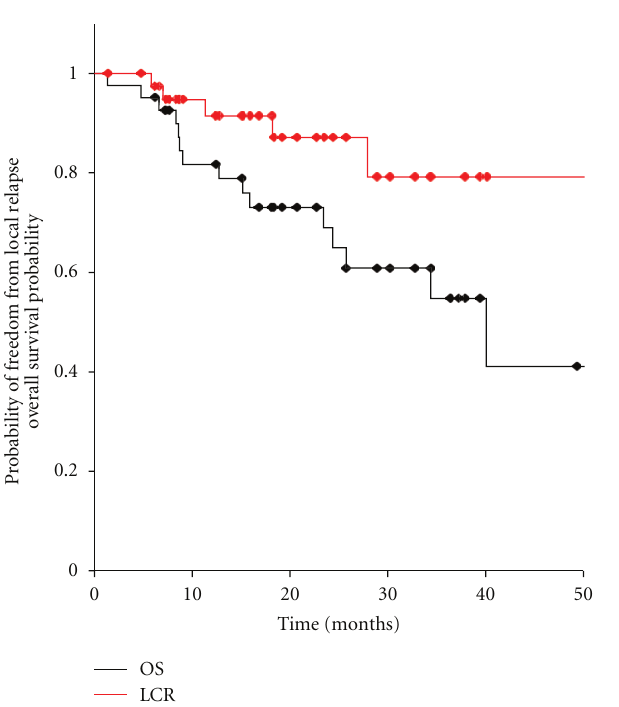
Figure 3: Kaplan-Meier curves for overall survival in 42 patients with oligo-recurrence cancer in the lung, cancers from colorectal cancer and ones from other origins.